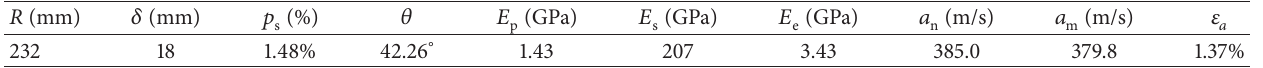
Table 1: Comparison of test and calculation.